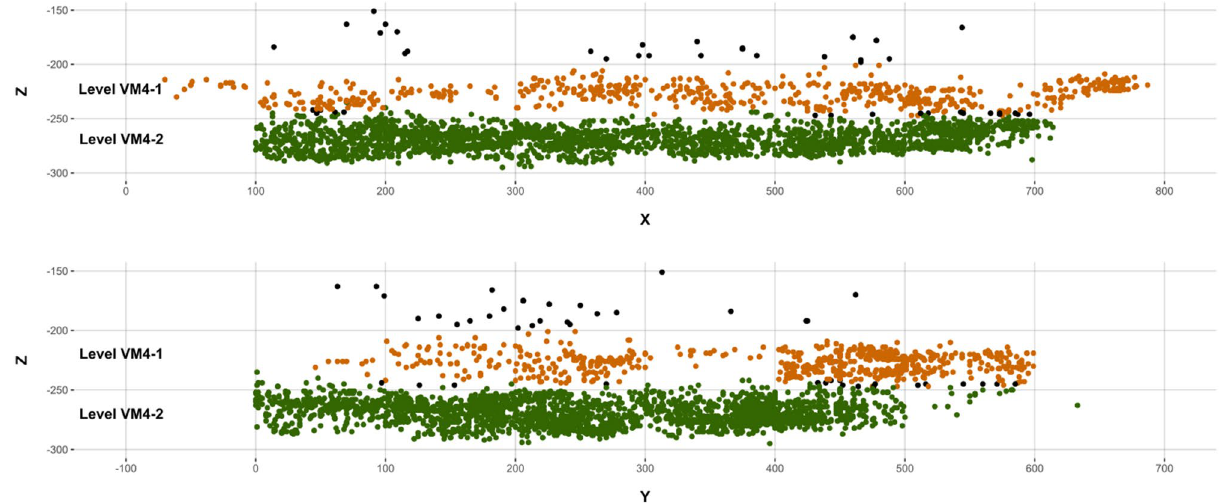
Figure 2. Scatter plot showing the spatial distribution of levels VM4-I (dark green) and VM4-II (brown), as identified using artificially intelligent systems. Black points indicate indeterminable points with < 80% confidence when being assigned to a